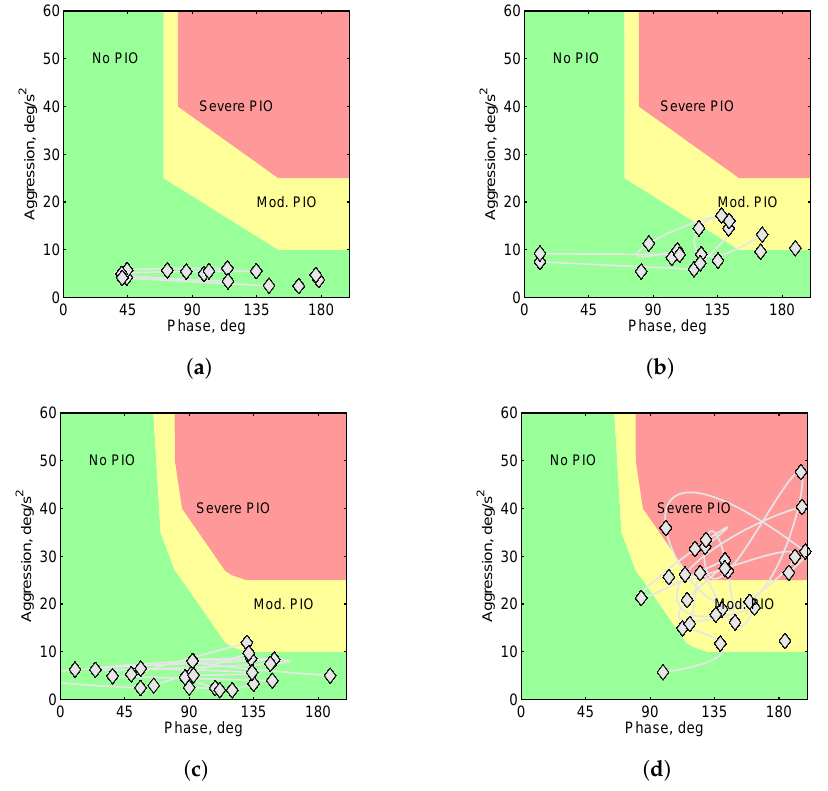
Figure 14. Comparison between PAC results for Rate Damped High (RDH) and Rate Damped Low (RDL) configurations recorded during the completion of the hover manoeuvre. ( a ) Day 2-Case 24-RDH-long; ( b ) Day 2-Case 23-RDL-long; ( c ) Day 2-Case 24-RDH-lat; ( d ) Day 2-Case 23-RDL-lat.